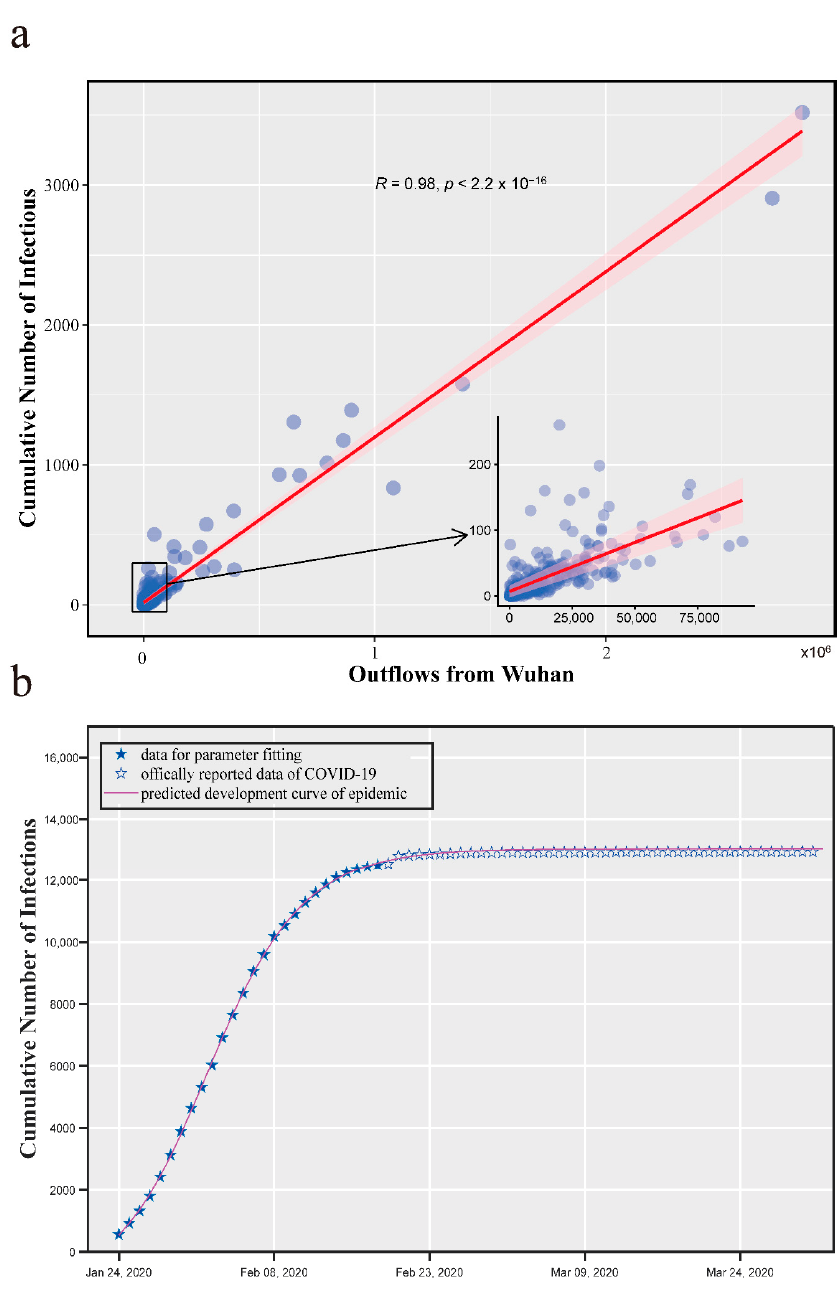
Figure 4. Human mobility and COVID-19. ( a ) Correlation analysis of the cumulative number of confirmed cases and the number of travelers from Wuhan; ( b ) development curve of COVID-19 predicted by the model.